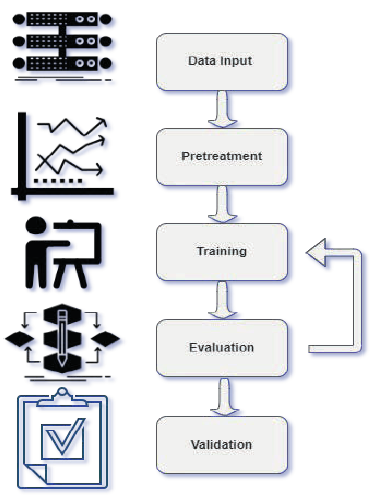
Fig. 2. Learning layer using machine learning